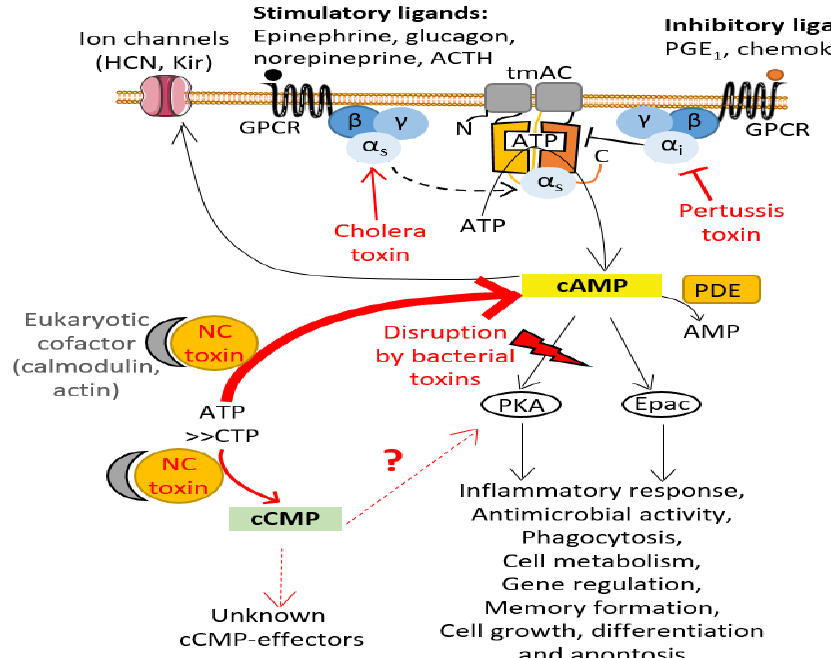
Figure 1. cAMP signaling pathway and its disruption by bacterial toxins. cAMP is synthesized by transmembrane AC (tmAC) (soluble AC, sAC, is not represented here), which are activated by the binding of an agonist to a G protein-coupled receptors (GPCRs) stimulating the transition of the heterotrimeric G protein alpha subunits G α s into its active GTP-bound state (see text for more details). cAMP activates various effectors such as protein kinase A (PKA) and guanine nucleotide-exchange Epac, which then regulate various cellular processes, including immune system responses. cAMP can also activate ion channels. Phosphodiesterases (PDE) regulate the degradation of cAMP by catalyzing its conversion into AMP. Bacterial pathogens have developed several strategies to manipulate the cAMP levels within host cells to disrupt intracellular signaling [1]: they can inject toxins (in red) into host cells that either alter the G α subunits responsible for activating or inhibiting eukaryotic tmAC, thus preventing host cells to properly regulate tmAC enzymatic activity (e.g., pertussis toxin (PT), cholera toxin (CT)), or directly produce uncontrolled, toxic levels of cAMP or other cNMPs (such as cCMP) once these NC toxins are specifically activated by their eukaryotic